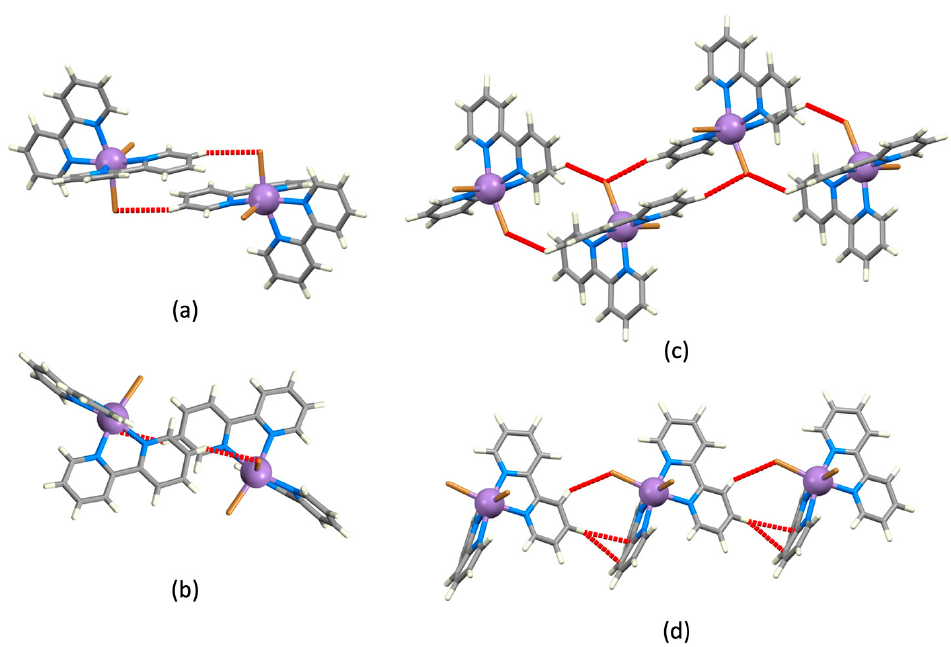
Figure 6. ( a , b ) Two views of the centrosymmetric motif in cis -[Mn(bpy) 2 Br 2 ] (CSD refcode TIRCON01 [37]) involving H5...Br contacts, and ( c ) propagation of chains supported by H5...Br contacts. ( d ) Chains are interconnected through H3...Br and CH... π interactions.